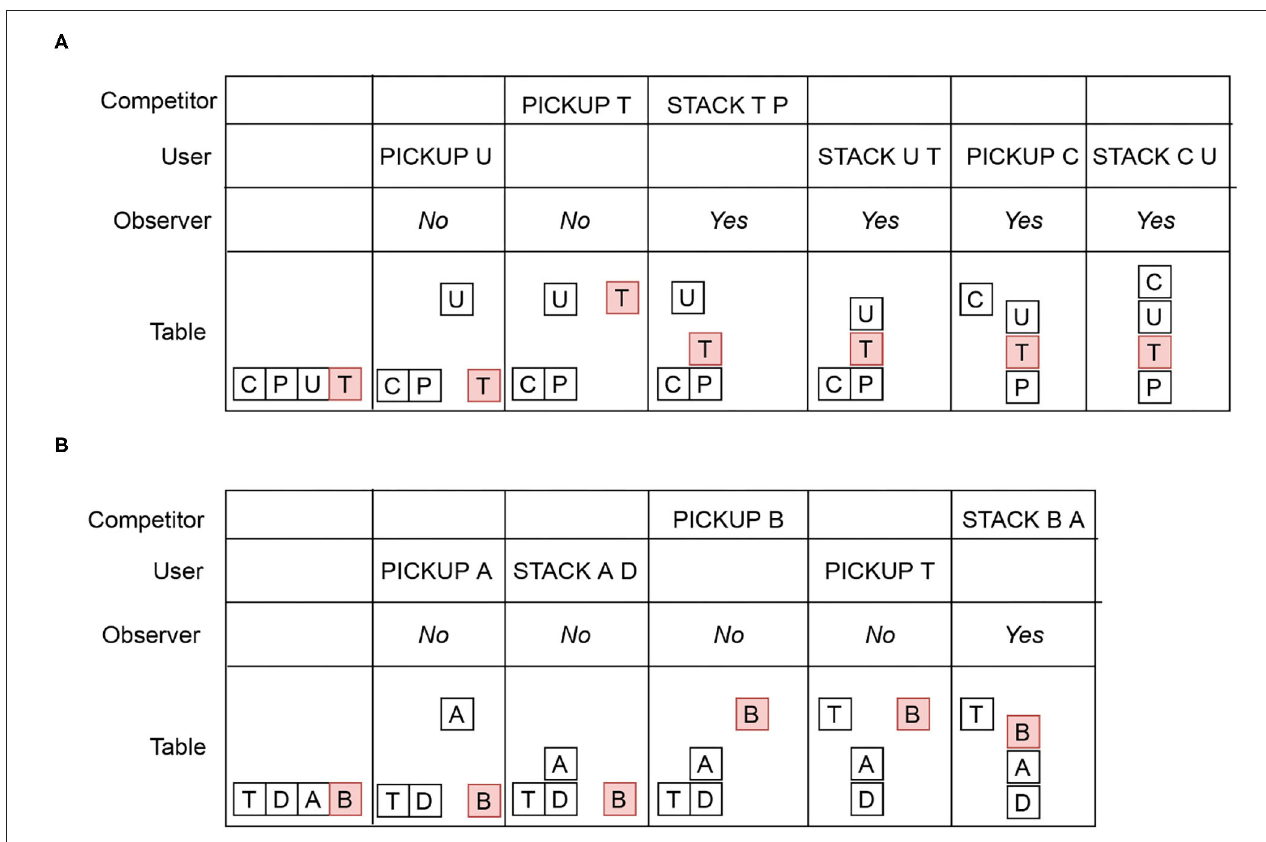
FIGURE 2 | (A) User and competitor intervention modeled in the Blocks Words domain, where u = (CUT) and d = (CUP). (B) User and competitor intervention where u = (BAD) and d = (TAD). Initially, all four blocks are on the table. An action in the user or competitor row indicates the Intervention Suffix. The Yes label in the observer’s row indicates that intervention is required. The No label indicates that intervention is not